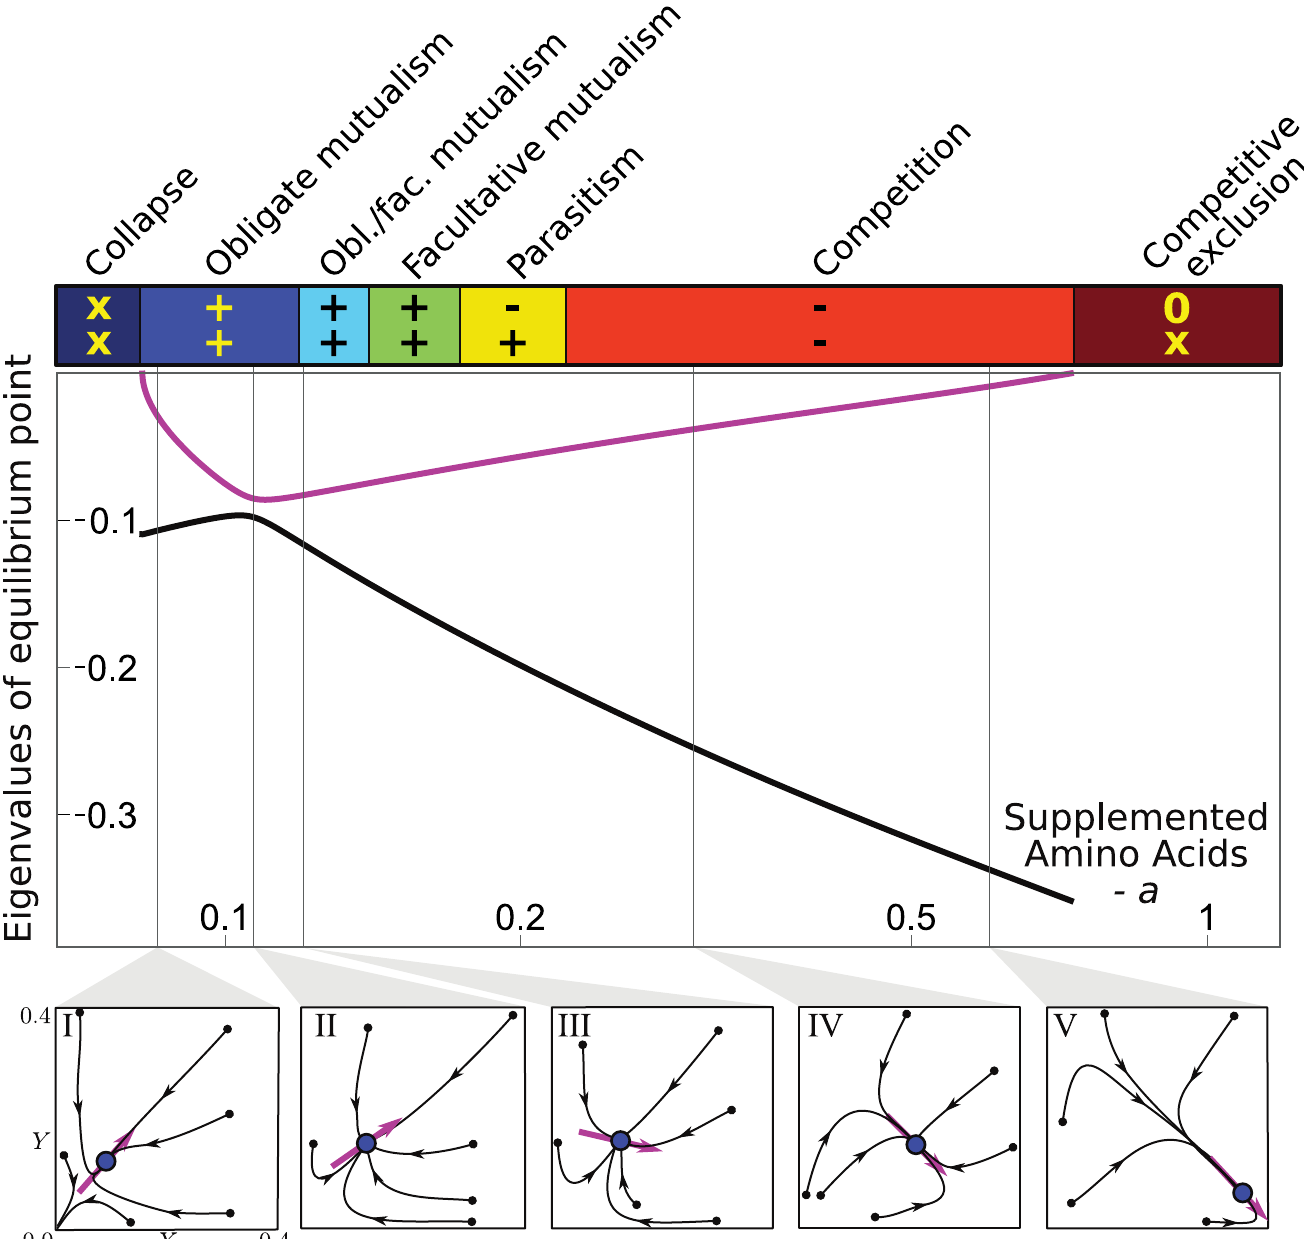
Fig 4. Eigenvector orientation predicts characteristic behaviors prior to population collapse. Main plot shows the two eigenvalues as a function of supplemented amino acids (black and magenta solid lines). Population collapse occurs when the slower eigenvalue (magenta solid line) reaches zero. Insets I – V show simulated population trajectories (solid, arrowed black lines) for different amino acid concentrations and starting from different initial population densities (small black dots). The eigenvector (magenta arrow) of the stable equilibrium point (blue dot) corresponds to the slower eigenvalue. Insets show that trajectories align to the eigenvector when the system is close to collapse. This indicates that the ratio of the densities of each strain within the population (i.e., f = X / Y ) relaxes faster than the total population size (i.e., n = X + Y ) when the system is close to extinction (inset I), whereas the opposite scenario occurs before the competitive exclusion regime (inset